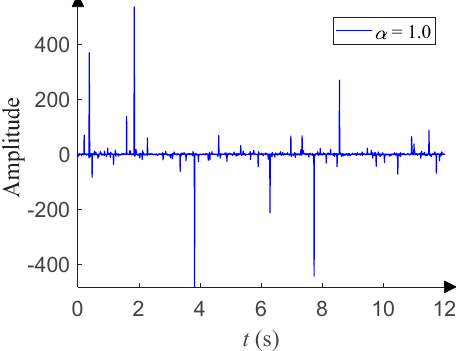
Figure 3. Time-domain waveform of α -stable distribution.